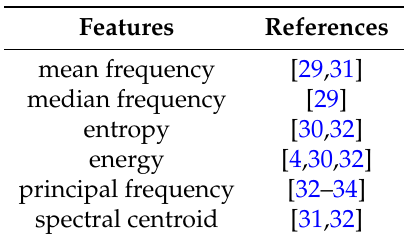
Table 3. Features extracted in frequency